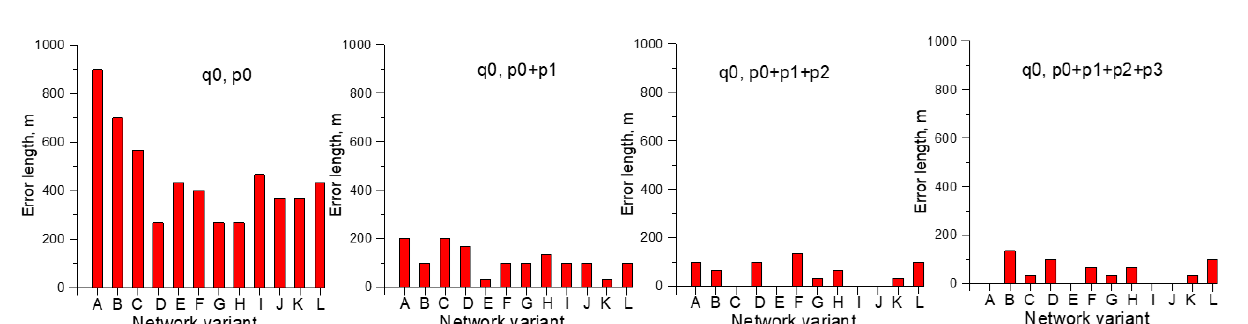
Figure 10. Length of the error depending on the network variant and the number of monitoring sensors applied.